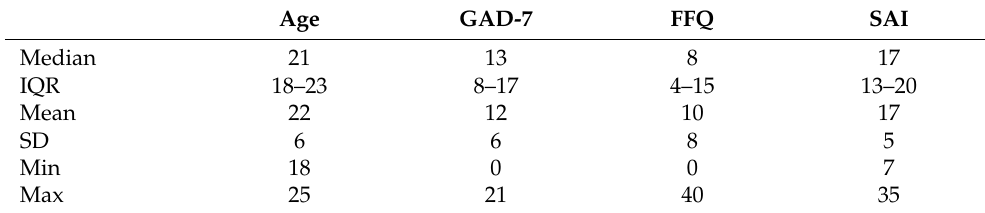
Table 3. Correlation analysis between key study variables for all